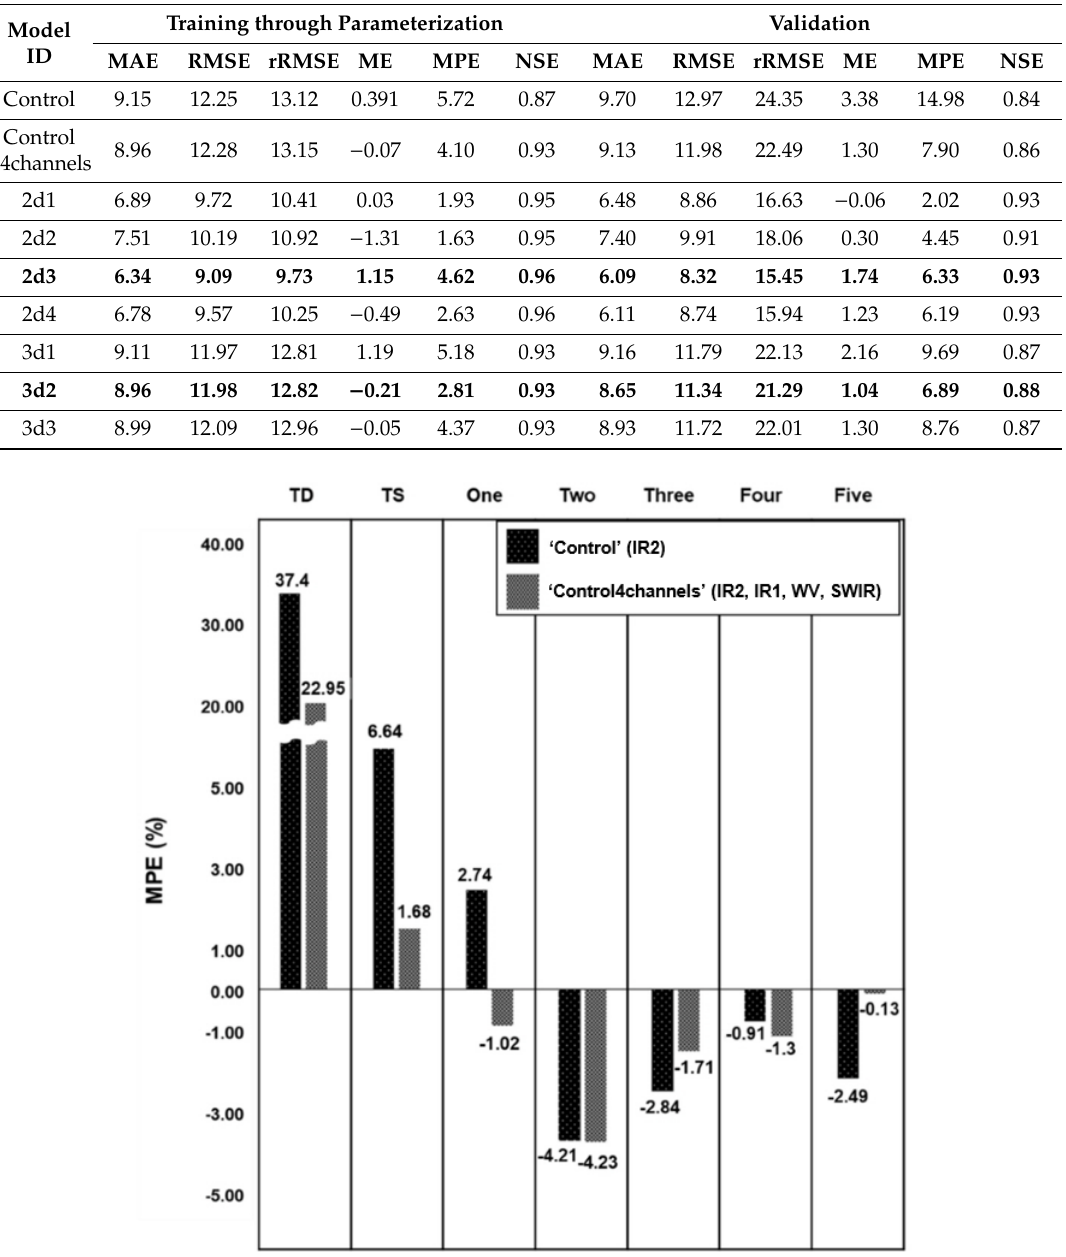
Table 4. Training (through parameterization) and validation results based on the test and validation datasets, respectively, for the nine CNN-based TC intensity estimation models. The model which resulted in the best validation accuracy for each of the 2D-CNN and 3D-CNN approaches is in bold. (Index (unit): MAE (kts), RMSE (kts), rRMSE (%), MPE (%) and NSE (0-1, unitless)). The best performing 2D-CNN and 3D-CNN based models are shown in bold.